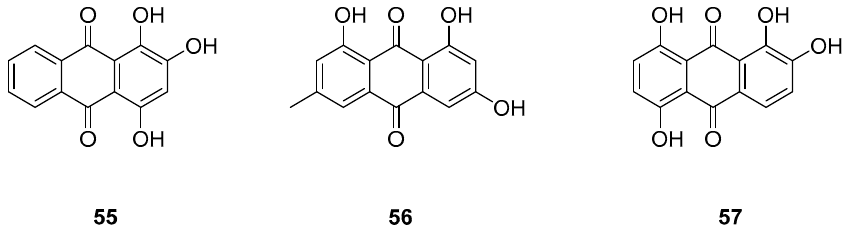
Figure 2. Inhibition biofilm formation on S. aureus strain MSSA 6538 by anthraquinone derivatives (from ref. [50]).